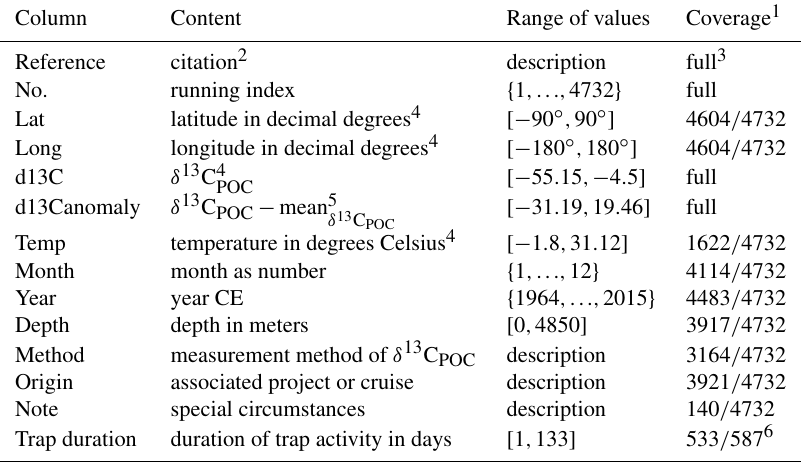
Table 3. Available data and meta-information: the columns of the raw data set correspond to the provided data and meta-information. Their names are given in the first column of this table. The second holds a short description of their content and the third their ranges of values. In the final column we give how well this data kind is covered relative to the size of the full data